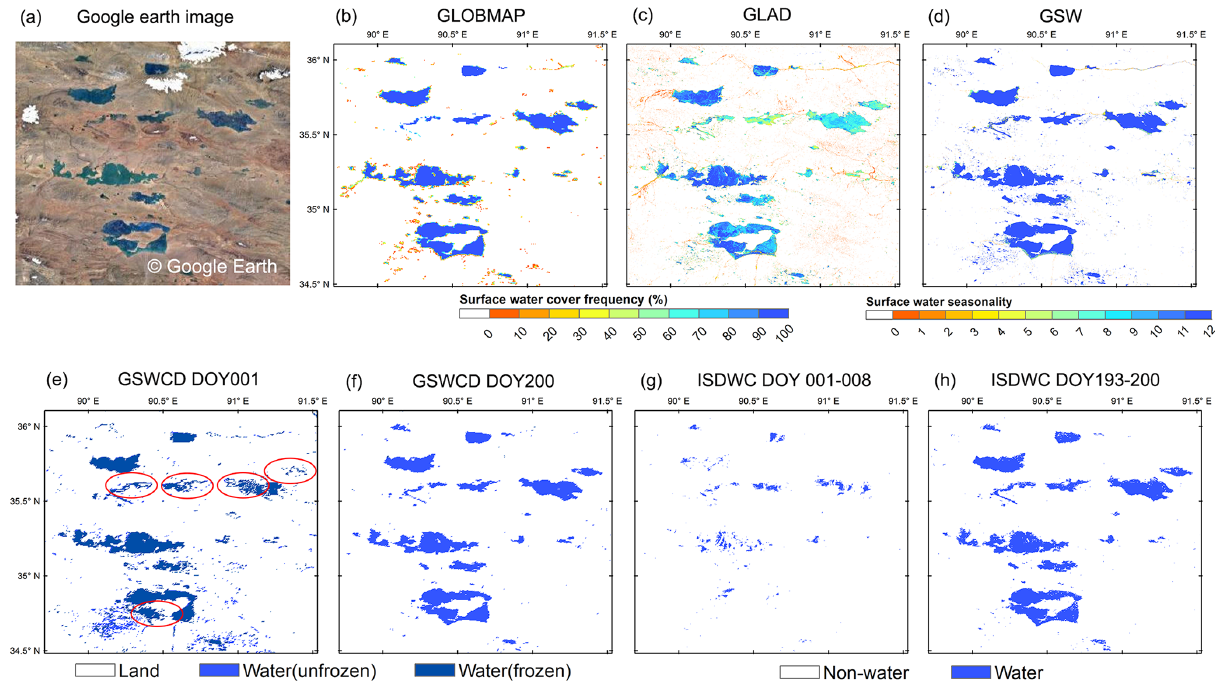
Figure 4. Comparison of surface water map of GLOBMAP SWF, GLAD, GSW, GSWCD and ISDWC for frozen lakes over bright surface in the northeastern Tibetan Plateau (34.48–36.10 ◦ N, 89.71–91.53 ◦ E) in 2015. (a) Google Earth high-resolution image (from Google Earth), (b) GLOBMAP surface water cover frequency map; (c) GLAD annual water percent and (d) GSW seasonality (source: EC JRC/Google). Surface water extent of GSWCD in (e) DOY001 and (f) DOY200 in 2015 and surface water extent of ISDWC in (g) DOY001–008 and (h) DOY193–200 in